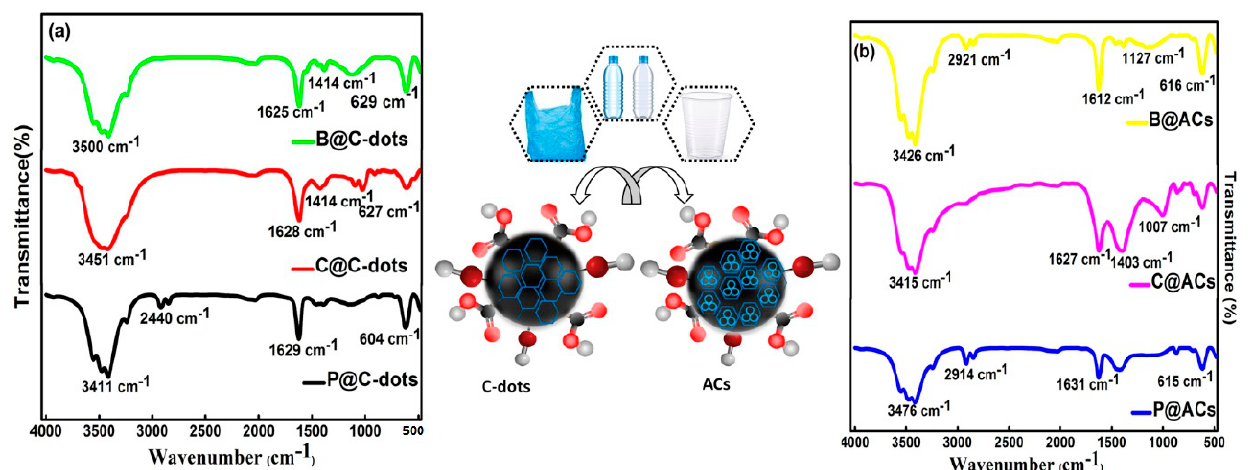
Figure 1. FTIR spectra of ( a ) C-dots and ( b ) ACs derived from single-use plastic bottle, cups and polybags.